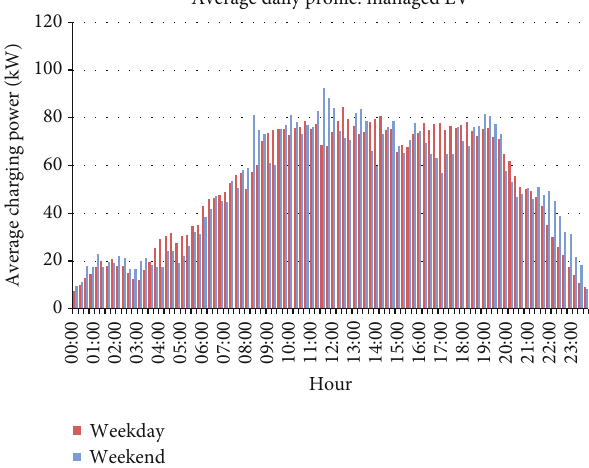
Figure 6: Average daily pro fi le for the managed EV